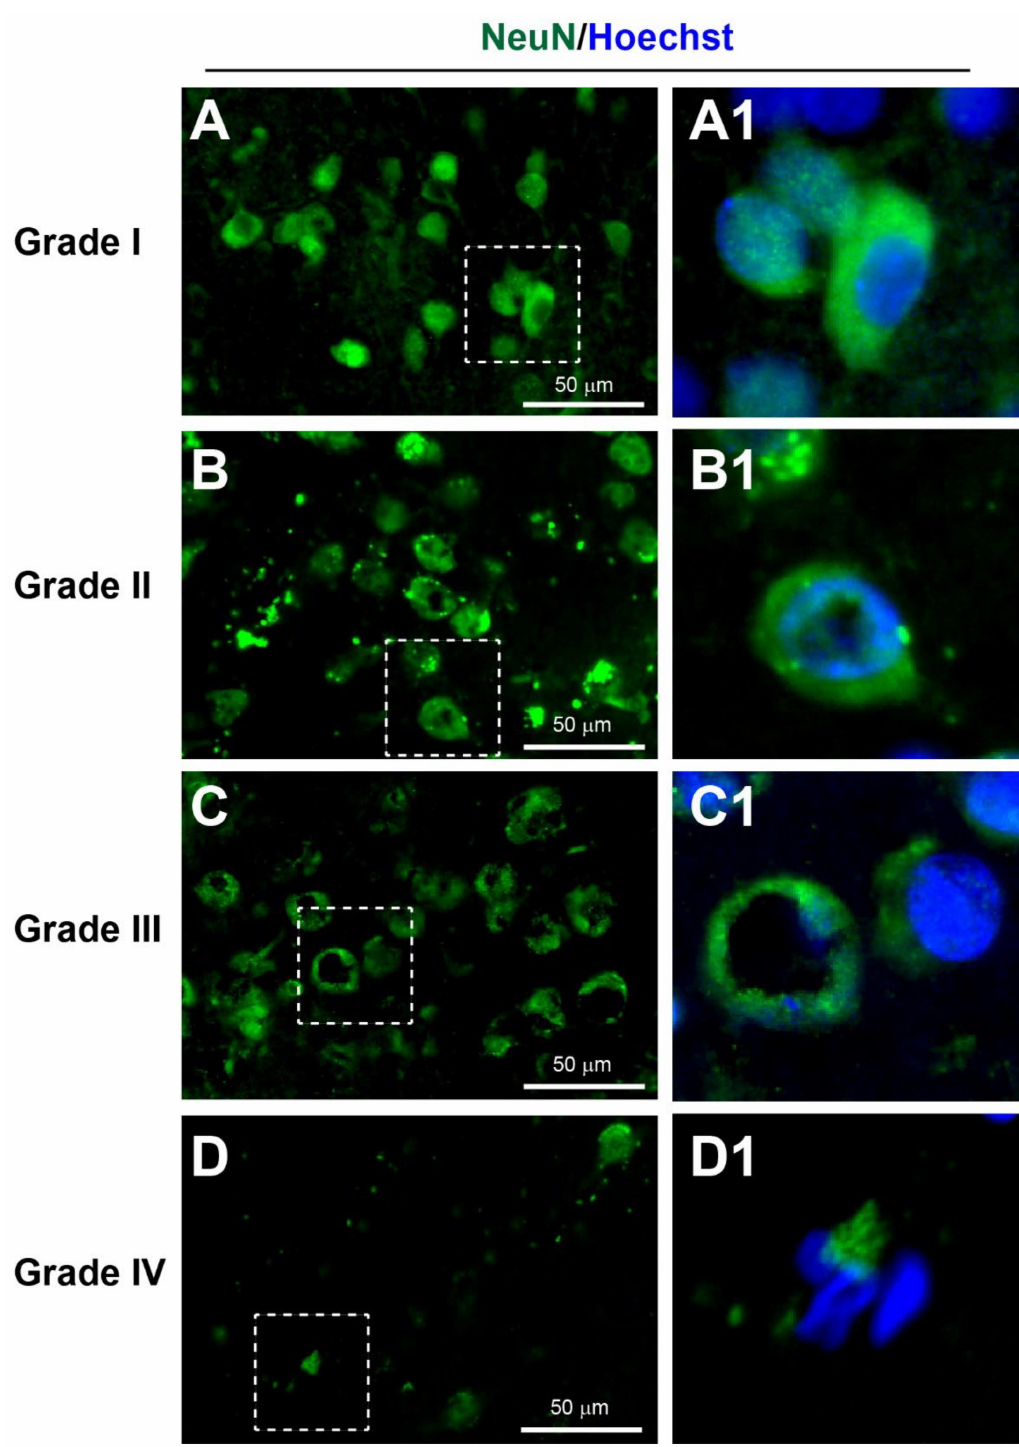
Figure 2. YHU grading system for neuronal injury in cerebral biopsies immunostained with NeuN (green) and Hoechst (nuclei, blue). ( A , A1 ) Neurones with limited injury display large round/or polygonal cell bodies (grade I). ( B , B1 ) Neurones with mild damage exhibit mild cellular shrinkage and/or small vacuolisation within the cytoplasm (grade II). ( C , C1 ) Neurones with moderate damage exhibit moderate cellular shrinkage and/or many with large cytoplasmic vacuolisations (grade III). ( D , D1 ) Severe neuronal death, indicated by atrophic cell bodies and few, if any, NeuN+ neurones (grade IV). ( A1 – D1 ) Enlarged images of the corresponding dashed boxes. Scale bar is 50 µ